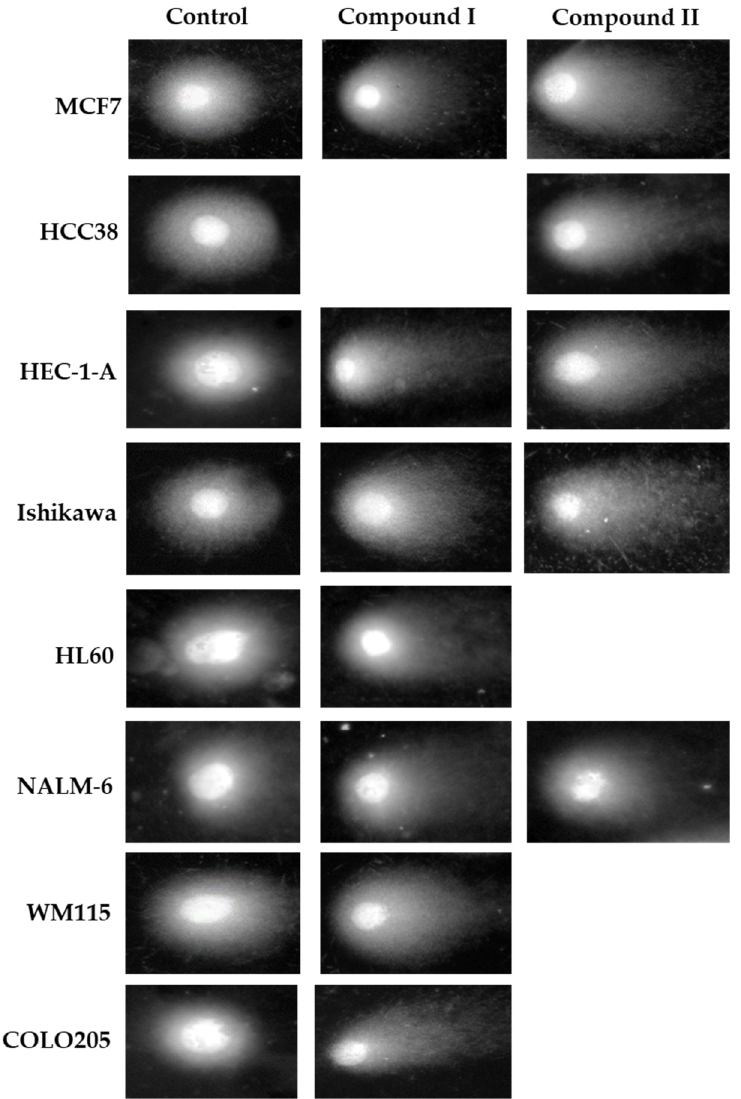
Figure 9. DNA comets obtained from MCF7, HCC38, HEC-1-A, Ishikawa, COLO205, HL60, NALM-6, and WM115. Cells were incubated with control and test compounds for 24 h at concentrations of the calculated IC 50.